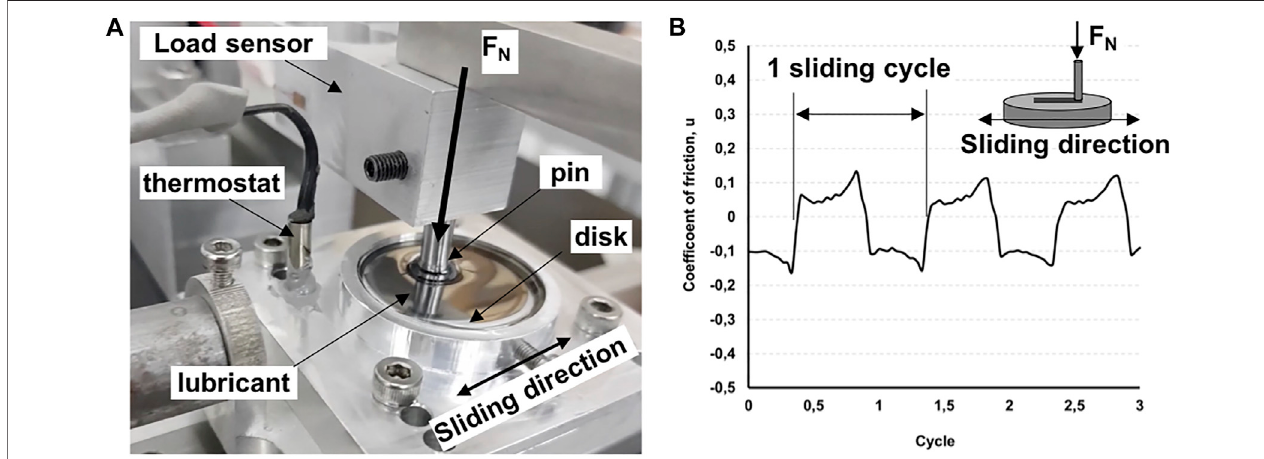
FIGURE 4 | A reciprocating pin-on-disc tribometer used to evaluate the friction and wear in this analysis (A) and the friction coef fi cient acquired from a friction test (B) .